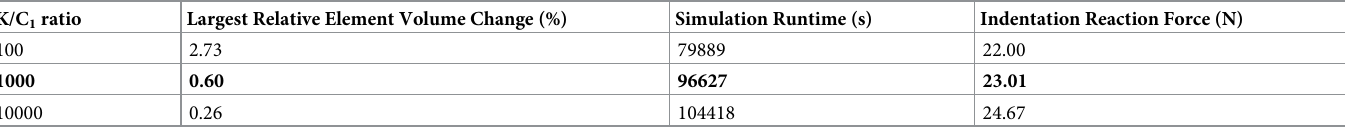
Table 2. Sensitivity of female upper leg model to changes in the K/C 1 ratio under experimental loading.